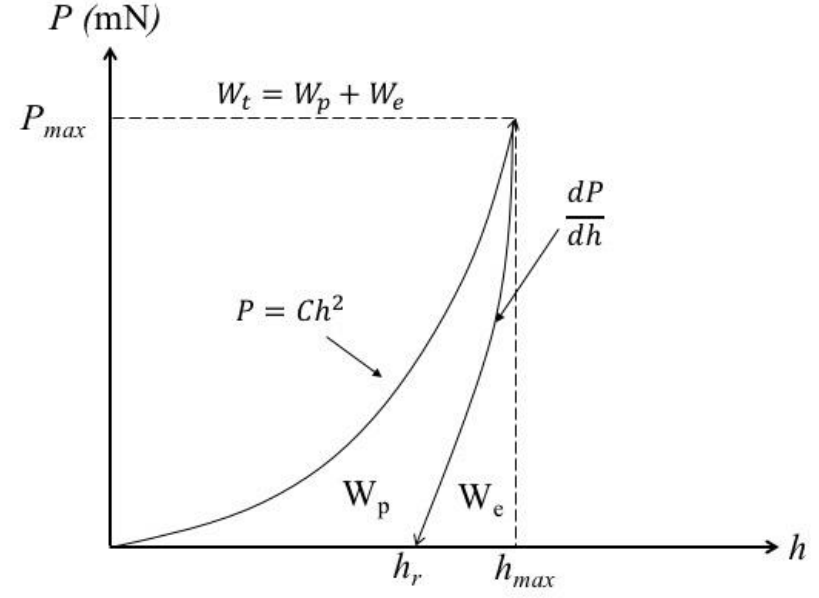
Figure 2. Indentation load–penetration depth curve from an indentation test.